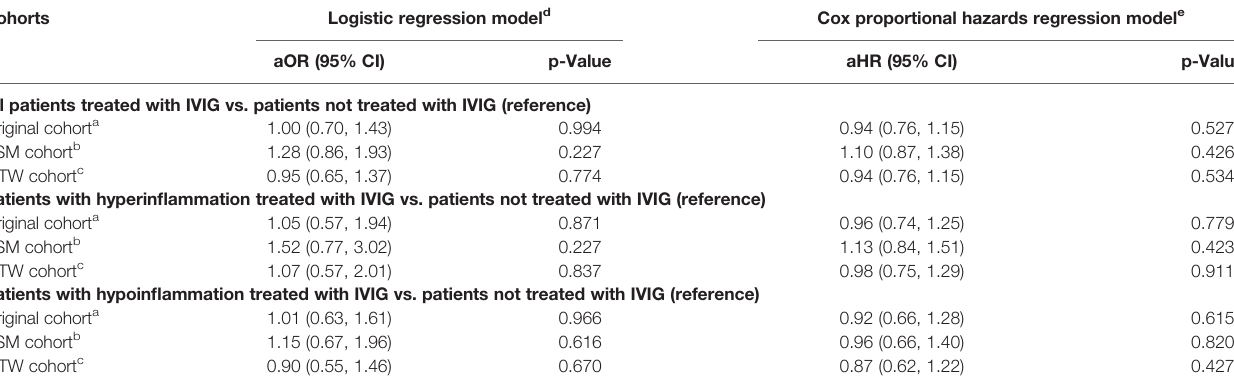
aHR,adjustedhazardratio;aOR,adjustedoddsratio;IPTW,inverseprobabilityoftreatmentweighting;IVIG,intravenousimmunoglobulin;PSM,propensityscorematching;IPTW,inverse probability of treatment weighting. a The original cohort was the overall cohort that met inclusion criteria and comprises 392 patients with IVIG therapy and 362 patients with non-IVIG therapy. b The propensity score-matched cohort comprises 253 patients with IVIG therapy and 253 patients with non-IVIG therapy. c Theentirecohortwithcompletedataoncovariateswasincluded inpropensityscoreinverseprobabilityoftreatment weightinganalysisandcomprises388patients withIVIGtherapyand 343 patients with non-IVIG therapy. d The logistic regression model was adjusted for the use of glucocorticoids, APACHE II scores, age, sex, and history of hypertension, diabetes, cardiovascular disease, CKD, and COPD. e The Cox proportional hazards regression model was adjusted for the same abovementioned baseline